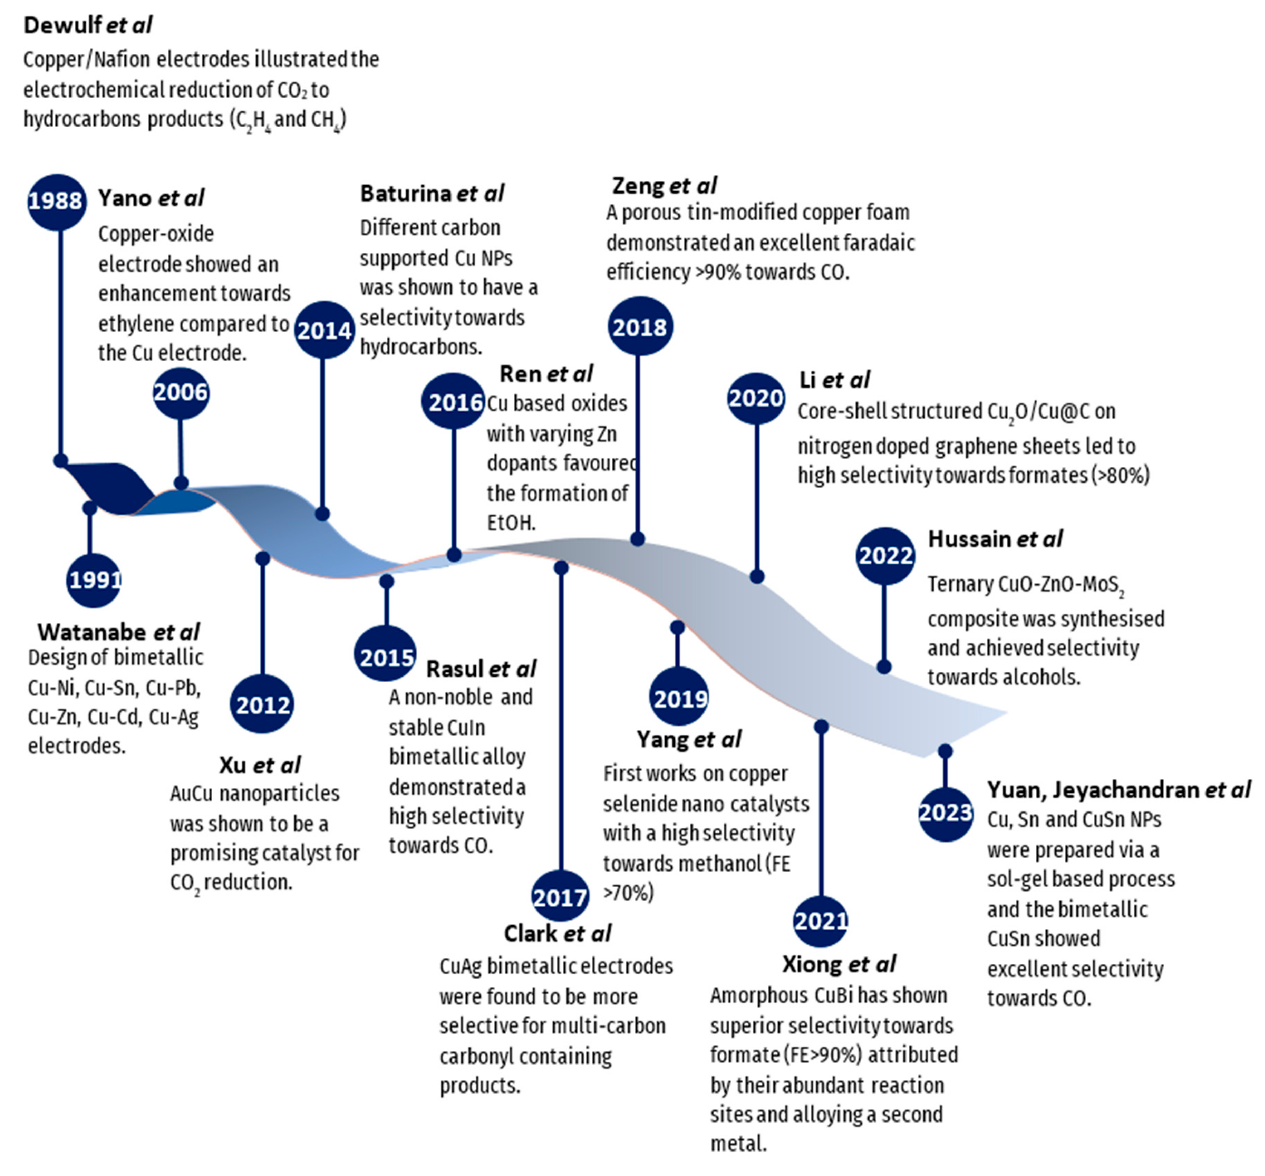
Figure 6. A timeline showing the development of Cu and Cu-based catalysts for the electrochemical reduction of CO 2 into value-added fuels from 1988 to 2023 (from left to right, respectively) [44–57]. As for other metals discussed previously, pure copper also lacks selectivity towards specific products, which is why a second metal is usually incorporated to modify its structure, for instance, by metal doping, alloying, changing morphology (e.g., core/shell), adjusting crystallinity [58], and more, with the aim to exploit the resulting synergistic, strain, and alloying effects (Figure 7). The incorporation of one or more metals into the Cu structure has been shown to improve stability, increase selectivity and activity, and minimize energy consumption, overall leading to a more efficient CO 2 RR, as discussed in the following